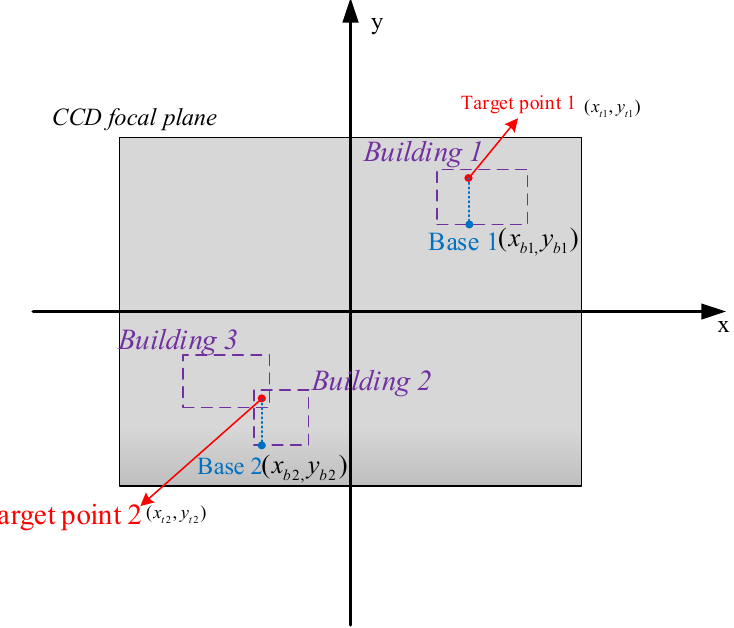
Figure 7. Overlapping prediction boxes in the image coordinate frame.